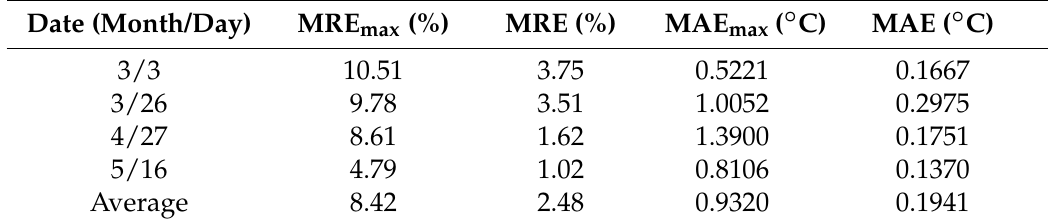
Table 5. Error between simulated and observed values for soil temperature.